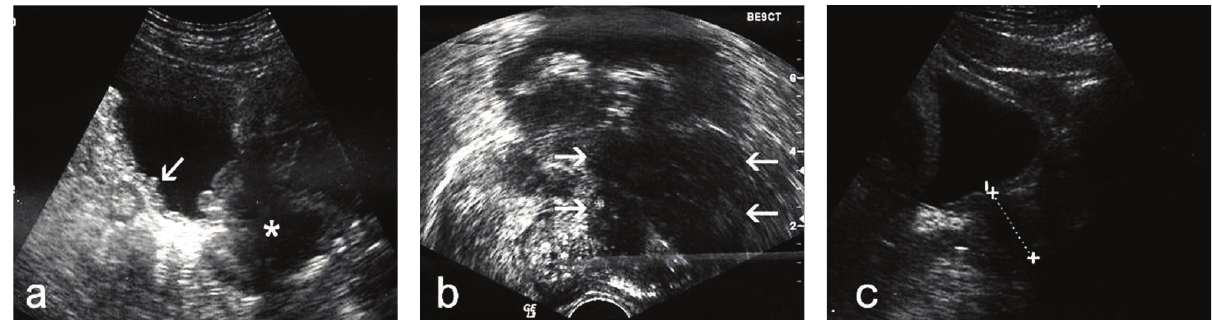
Figure 2: Sonographic imaging of the case. (a) Transabdominal US of the pelvis (sagittal section) shows an enlarged and markedly hypoechoic prostate (asterisk), with indistinct borders. Irregular thickening of the bladder wall is also noted (arrow). (b) Transrectal US confirms infiltration of the prostate by a bulky, lobulated, hypoechoic mass (arrows) which also involves the base of the penis. (c) Transabdominal US (comparable section with (a)) shows resolution of the infiltrative process.